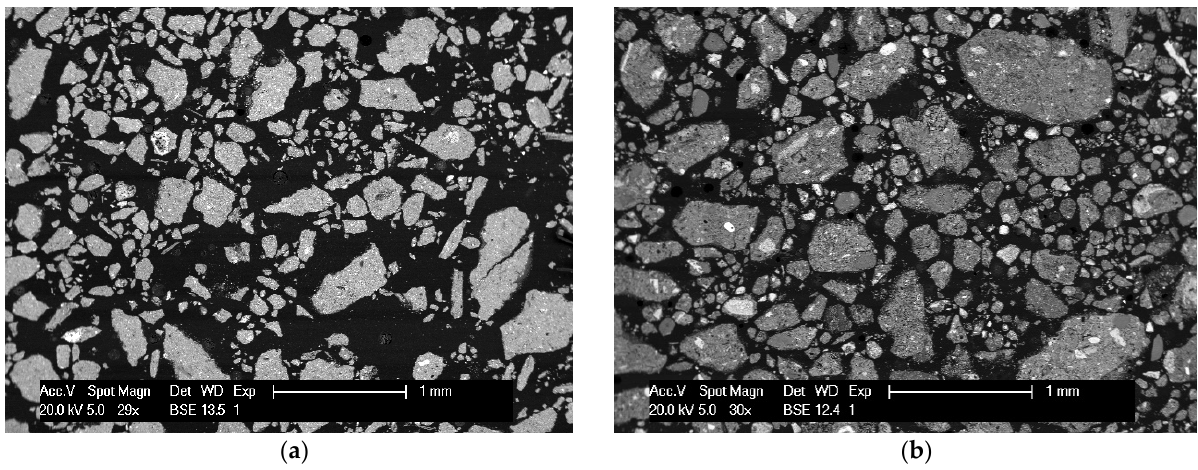
Figure 8. SEM-BSE image of ( a ) the non-magnetic phase and ( b ) the magnetic phase after the wet magnetic separation (simultaneous water leaching and magnetic separation).